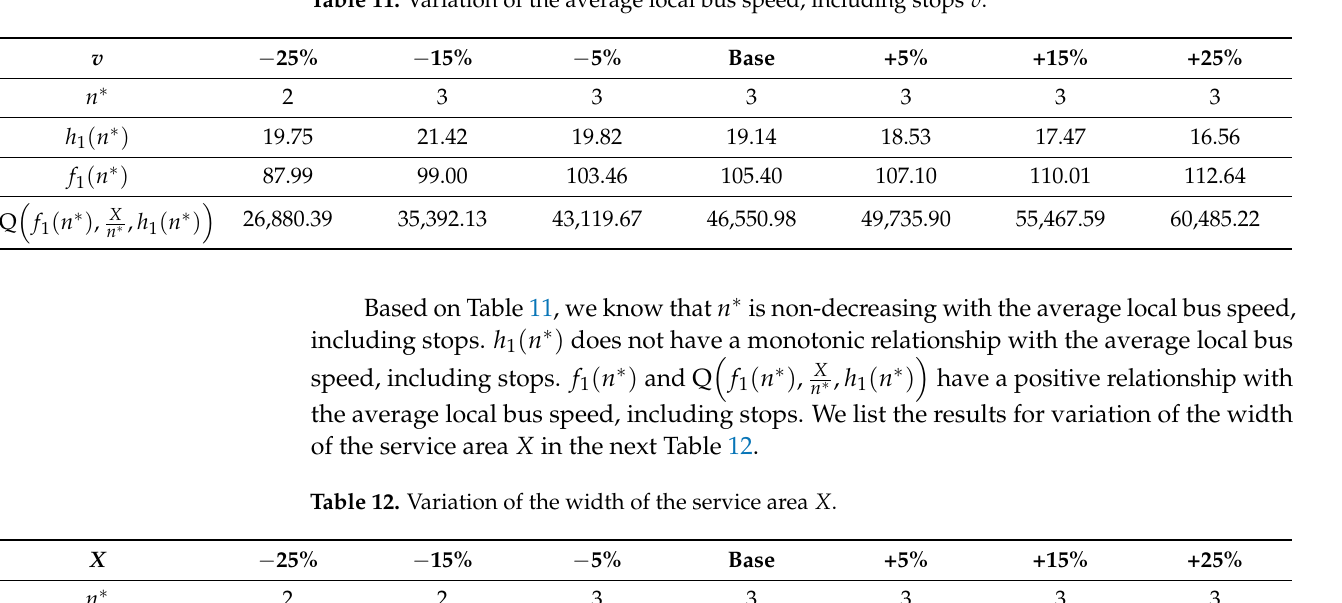
Table 11. Variation of the average local bus speed, including stops v .